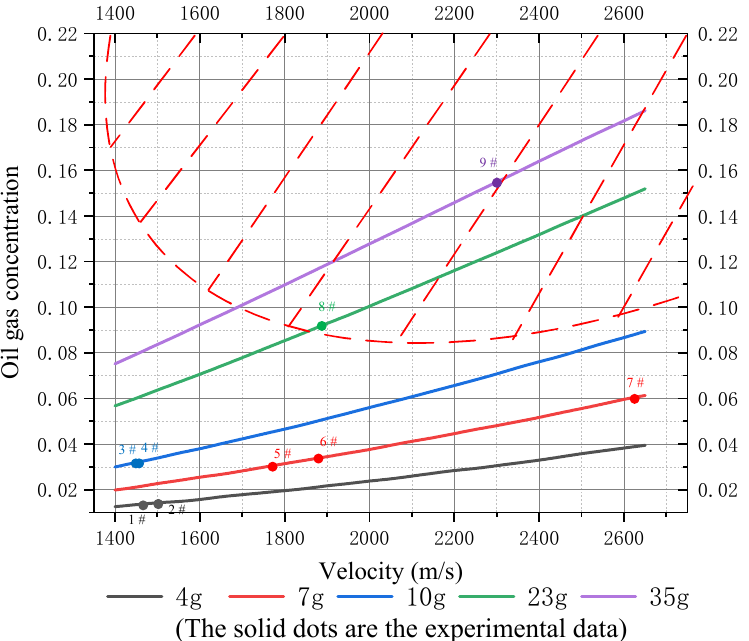
Figure 13. Variation in oil–gas concentration (volume fraction) in the fuel tank with velocity subjected to inert fragments with different masses.